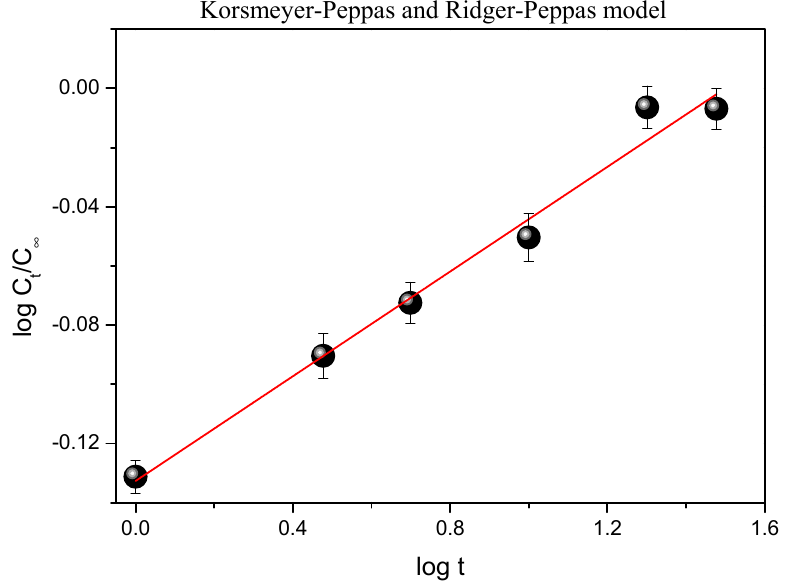
Figure 7. Power-law model for release process of DOX from m MWCNTs. Data are presented as mean ± SD ( n = 3).